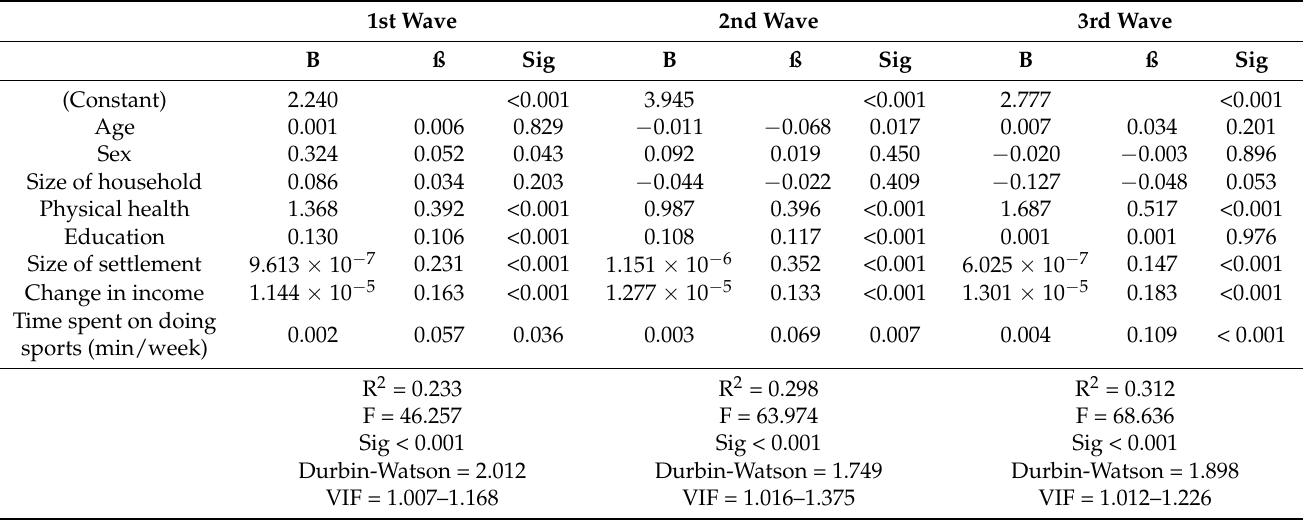
Table 6. Regression models on WHO-5 in the different waves of the pandemic. 1st Wave 2nd Wave 3rd